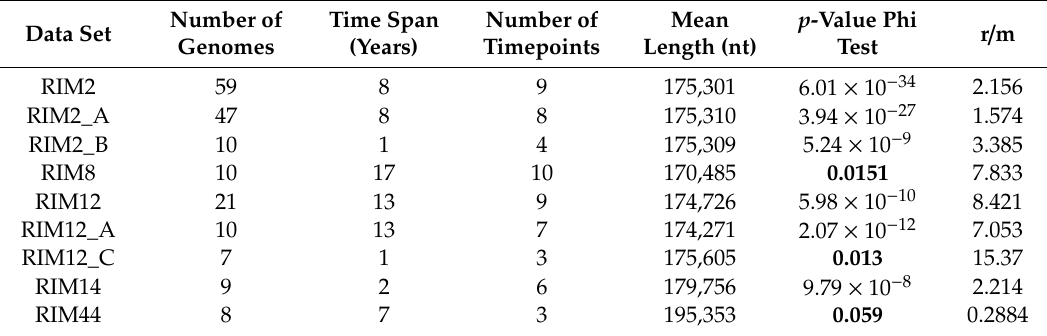
Table 1. Data sets